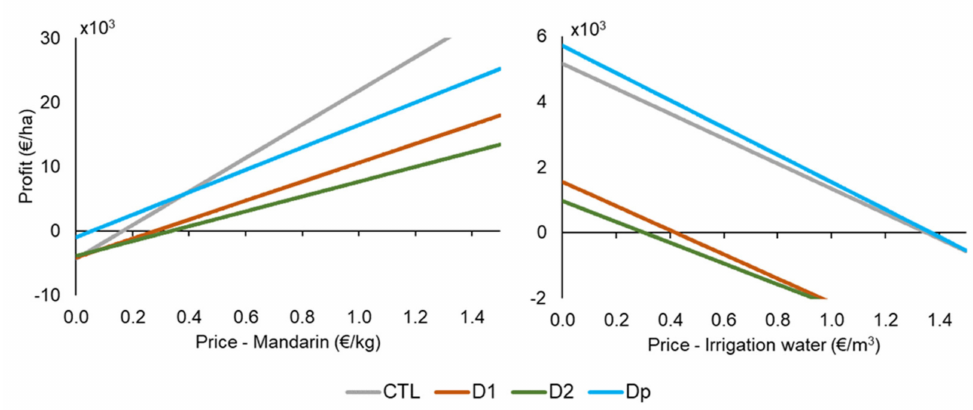
Figure 5. Sensitivity analysis of the annual profit (EUR/ha) to the variation in the price of mandarin and irrigation water, in mandarin monoculture (CTL), diversification D1 (D1), diversification D2 (D2), and diversification Dp (purslane and fava bean as